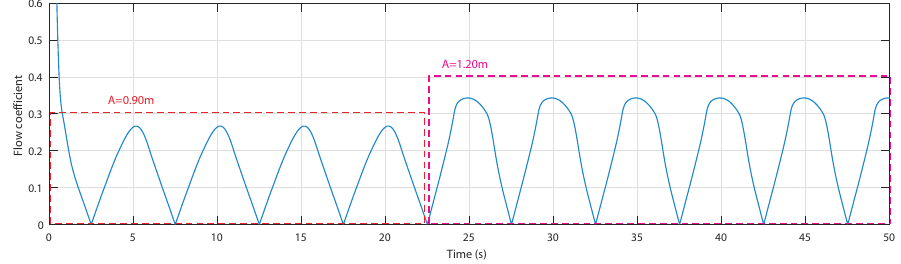
Figure 5. Flow coefficient vs. time for two wave amplitudes [31].